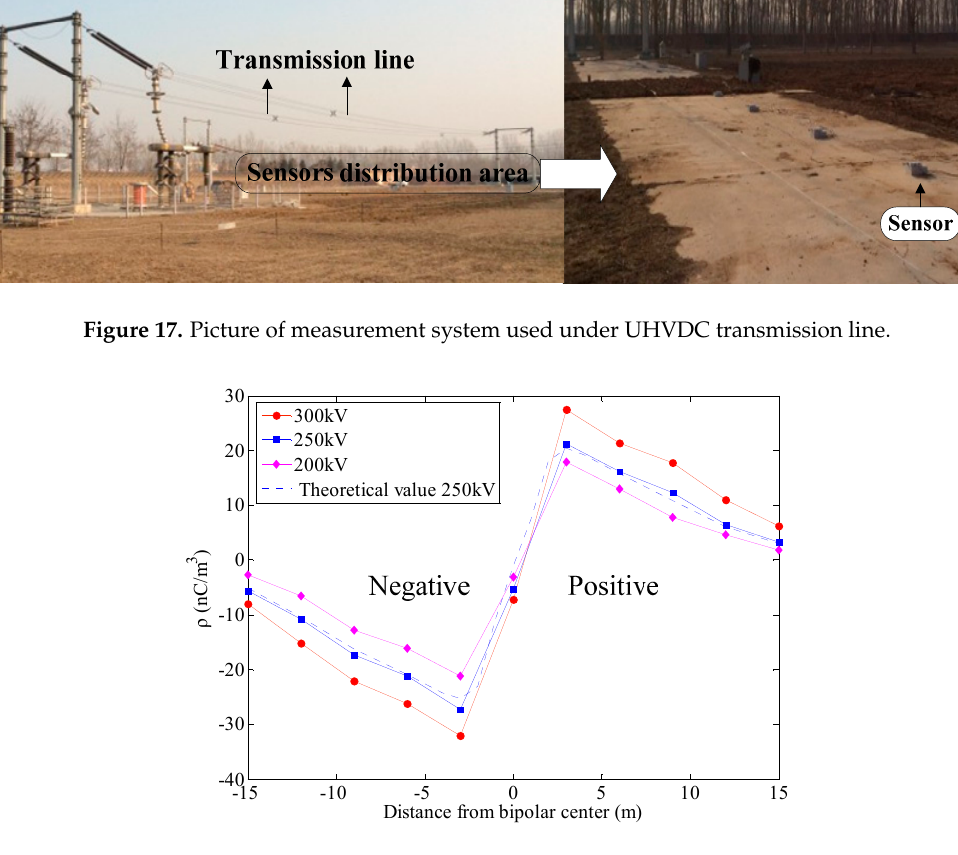
Figure 18. Lateral distribution test results of space charge density under different voltage level.